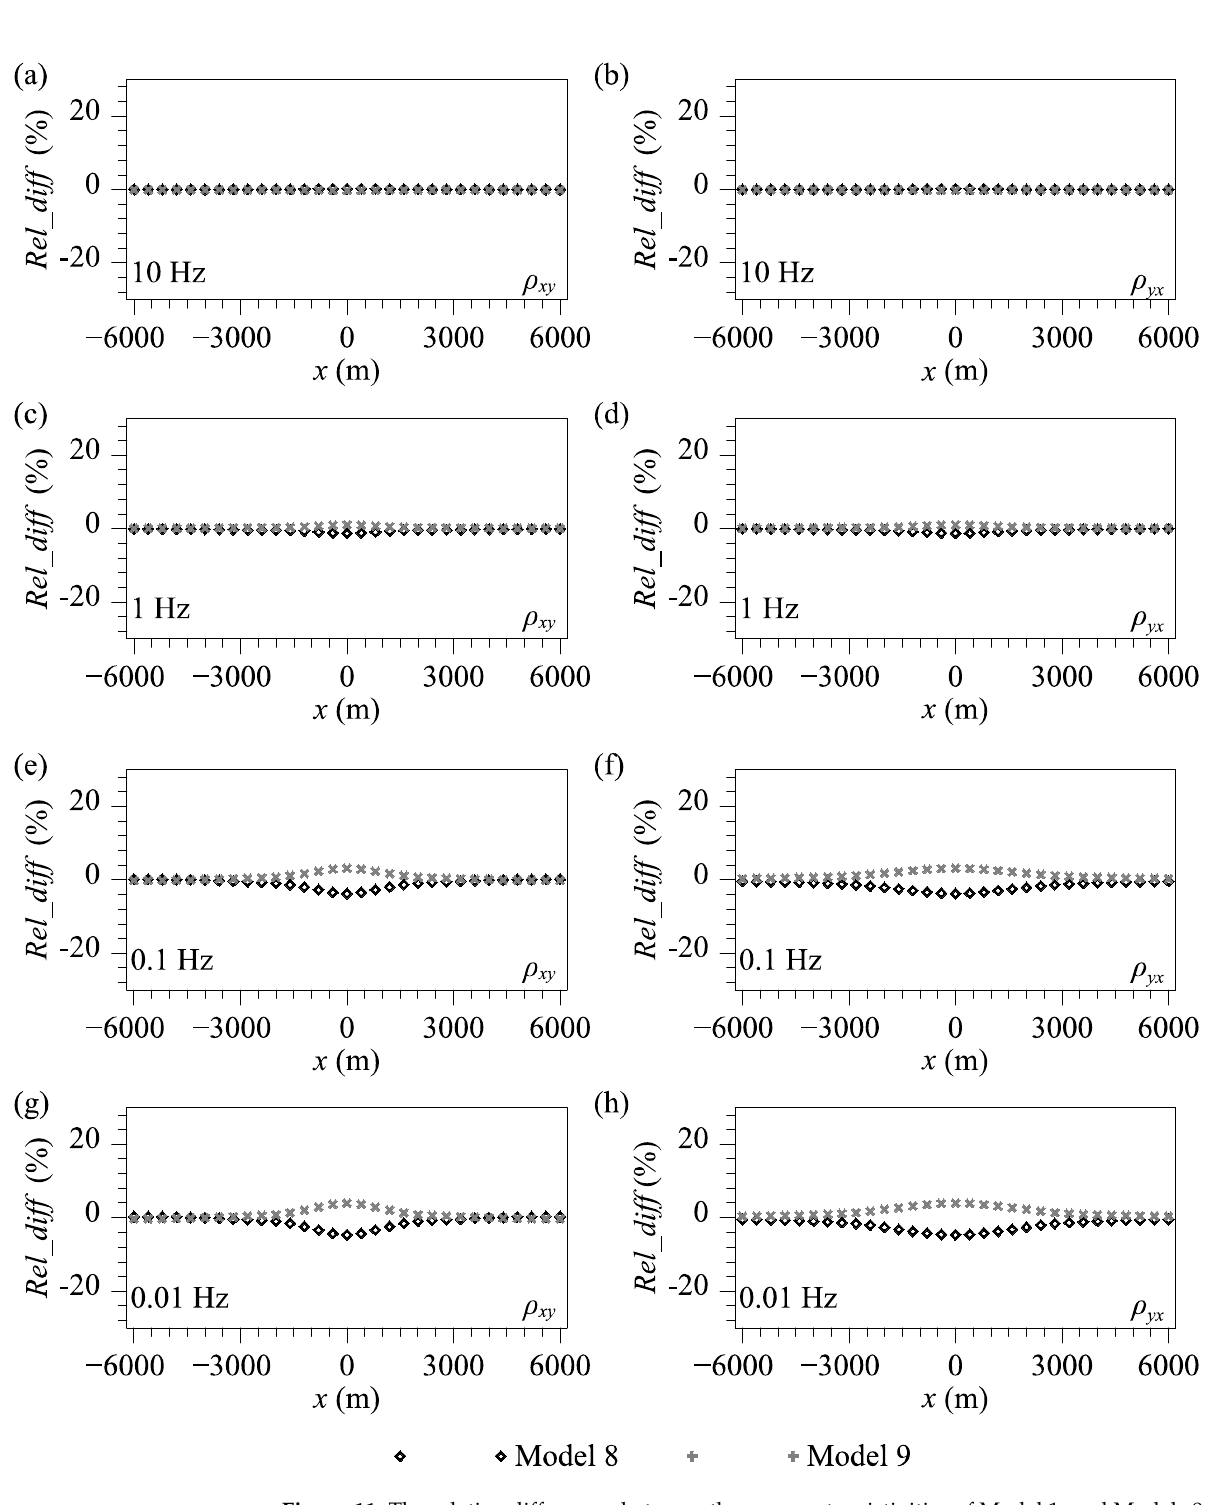
Figure 11. The relative differences between the apparent resistivities of Model 1, and Models 8 and 9. Models 8 and 9 are obtained by perturbing the reservoir resistivity of Model 1 by 20% of its value. ( a , b ) are for 10 Hz, ( c , d ) are for 1 Hz; ( e , f ) are for 0.1 Hz, and ( g , h ) are for 0.01 Hz.